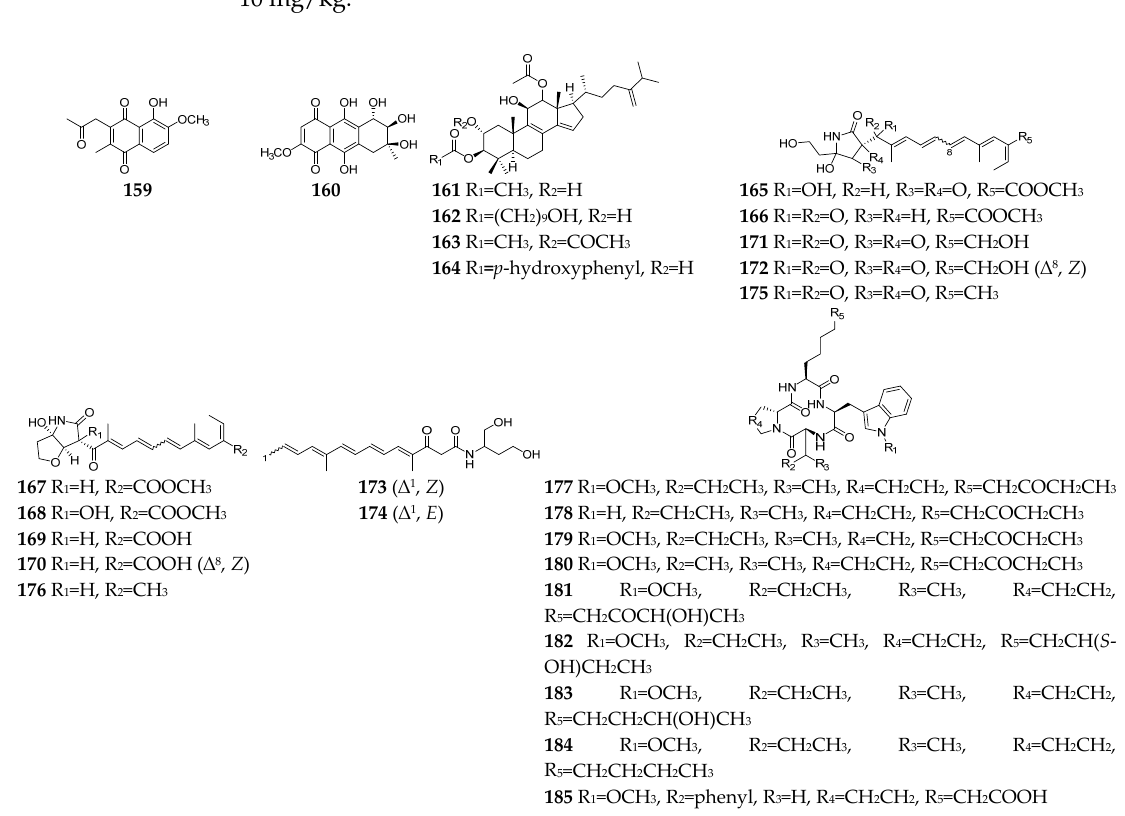
Figure 7. Fusarium -derived antiparasitic SMs ( 159–185 ).